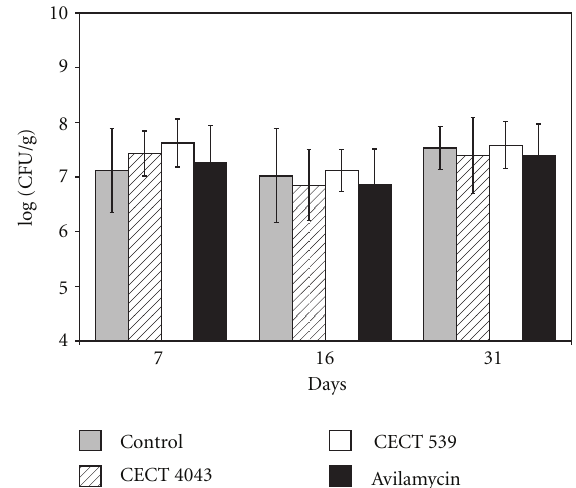
Figure 2: Viable plate counts (means ± standard deviations) of col- iforms in the caeca of Ross 308 broilers fed with a non supplemented diet (control) or diets supplemented with the probiotic Lact. casei CECT 4043 or L. lactis CECT 539 preparations or